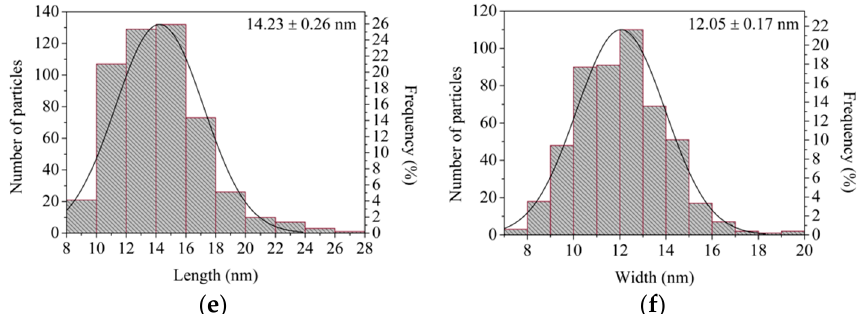
Figure 9. Transmission electron micrograph of gold nanoparticles obtained from ( a ) Aldrich reagent and ( b ) gold coatings; ( c ) length and ( d ) width of Au nanoparticles from Aldrich, and ( e ) length and ( f ) width of Au nanoparticles obtained from coatings.